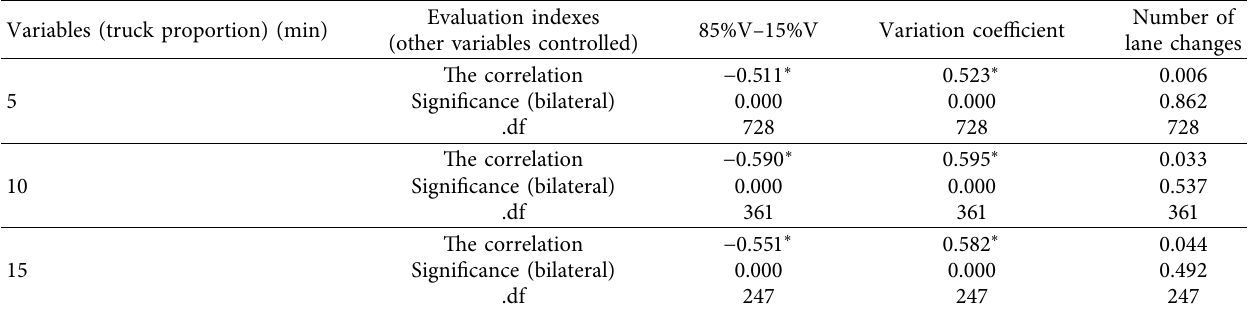
Table 4: The relationship among indicators of traffic flow parameters in partial correlation analysis. Variables (truck proportion) (min)